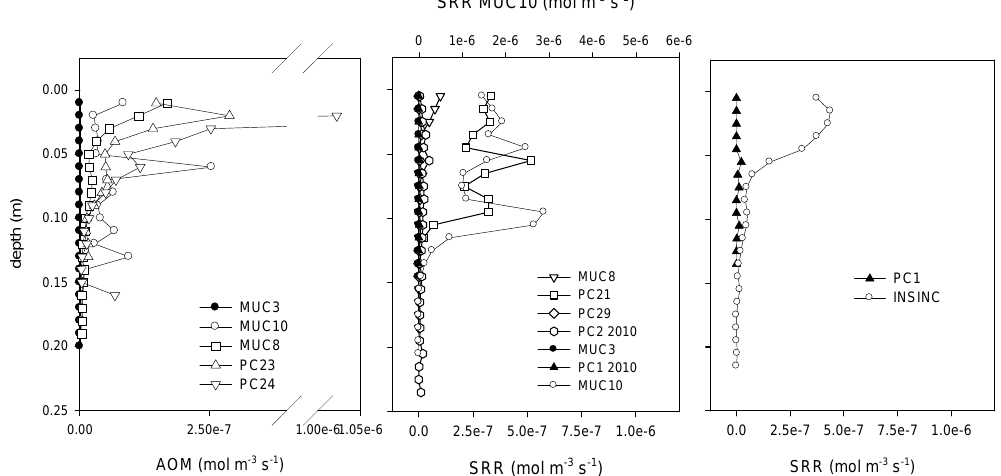
Fig. 6. Microbial rates. (A) AOM rates measured on retrieved cores. Although the scatter was large and rates low despite relatively high methane and sulfate concentrations, AOM activity was detectable in the upper 7cm. (B) The SR rates measured on retrieved cores. Values from MUC10 were very high and therefore plotted on a separate x axis above the graph. The SR activities are restricted to the upper 10– 13cm. (C) In situ measured SR rates show only significant activities above 7cmb.s.f. The black symbols represent measurements at the reference